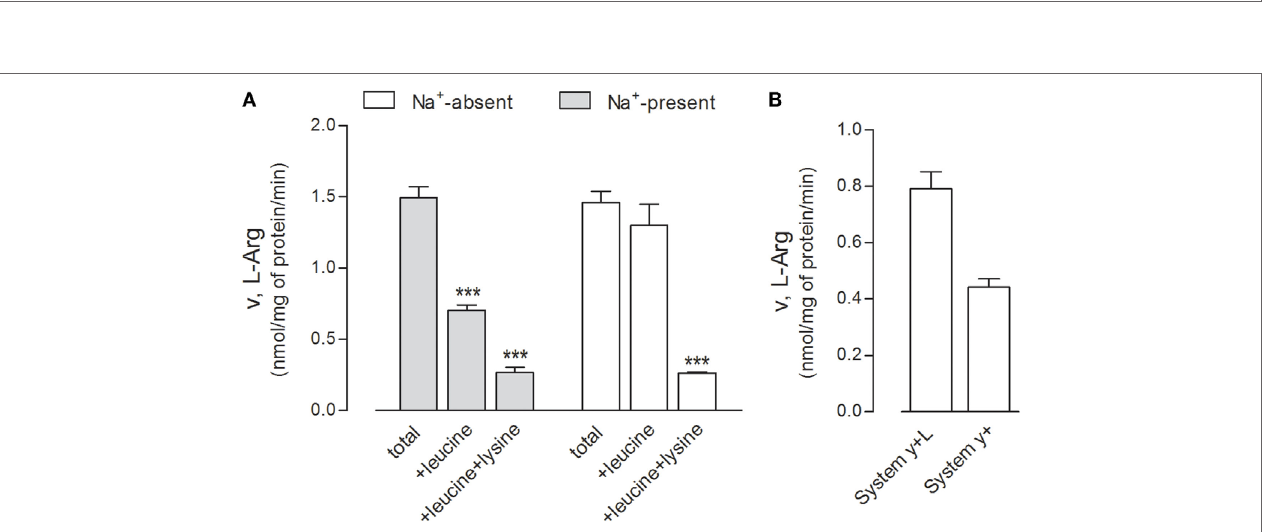
FigUre 4 | (a) A549 cells were washed in Earle’s balanced salt solution (EBSS) (Na + -present) or Na + -free NMG-EBSS (Na + -absent), as indicated; arginine uptake was then assayed with 1-min incubation in the same solution supplemented with l -[ 3 H]arginine (0.05 mM; 3 μ Ci/ml) in the absence (total) or in the presence of 2 mM leucine or 2 mM leucine + lysine. Data are mean ± SD of five independent determinations in a representative experiment, which, repeated twice, gave comparable results. *** p < 0.001 vs . total uptake with one-way ANOVA followed by Bonferroni post hoc test. (B) Data shown in Panel (a) were employed to calculate the relative contribution of systems y + L and y + to total arginine uptake (see Materials and Methods and Results).